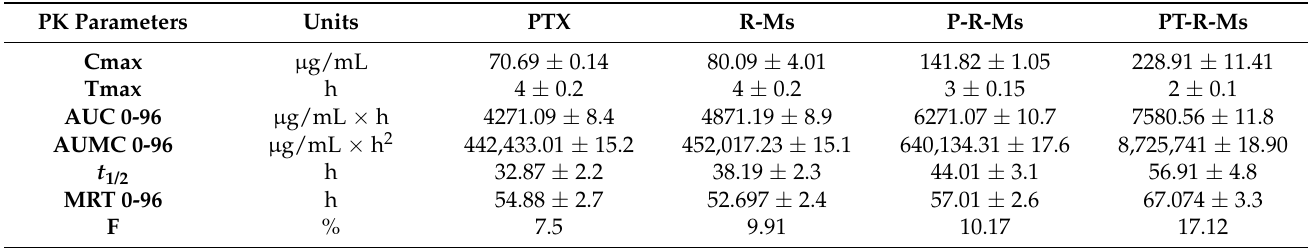
Table 4. Pharmacokinetic parameters and relative oral bioavailability obtained after oral administration of PTX suspension in deionized water, Ms, R-Ms, P-R-Ms, and PT-R-Ms to mice through oral